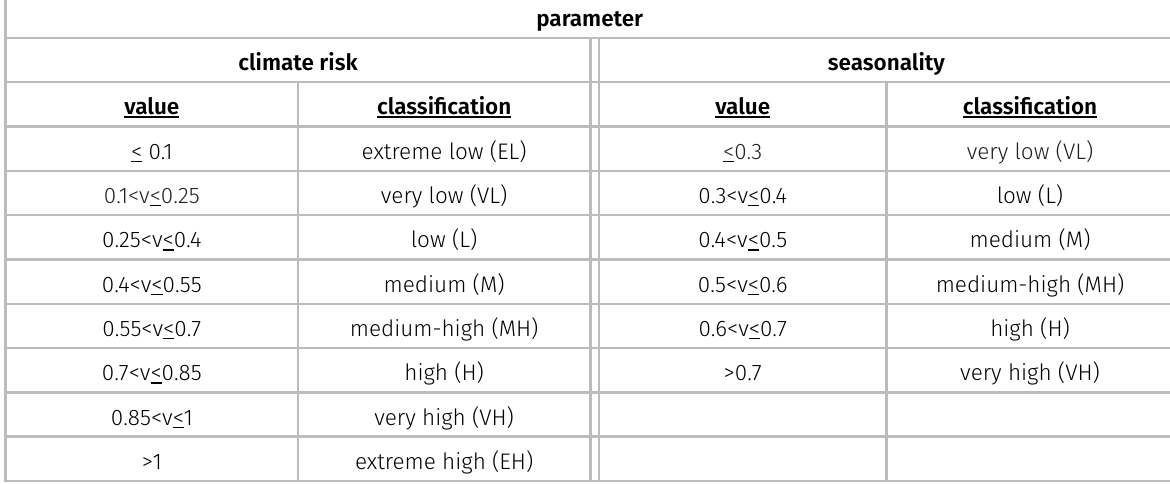
Table I. Indexes for classification of climate risk and seasonality of Marandu palisade grass herbage accumulation rate (indexes were determined